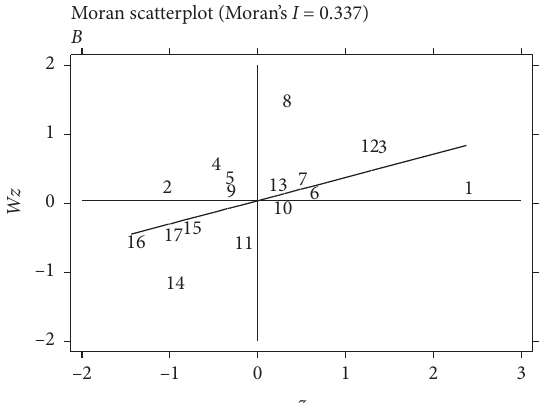
Figure 5: Moran scatter plot of urban sustainability level in